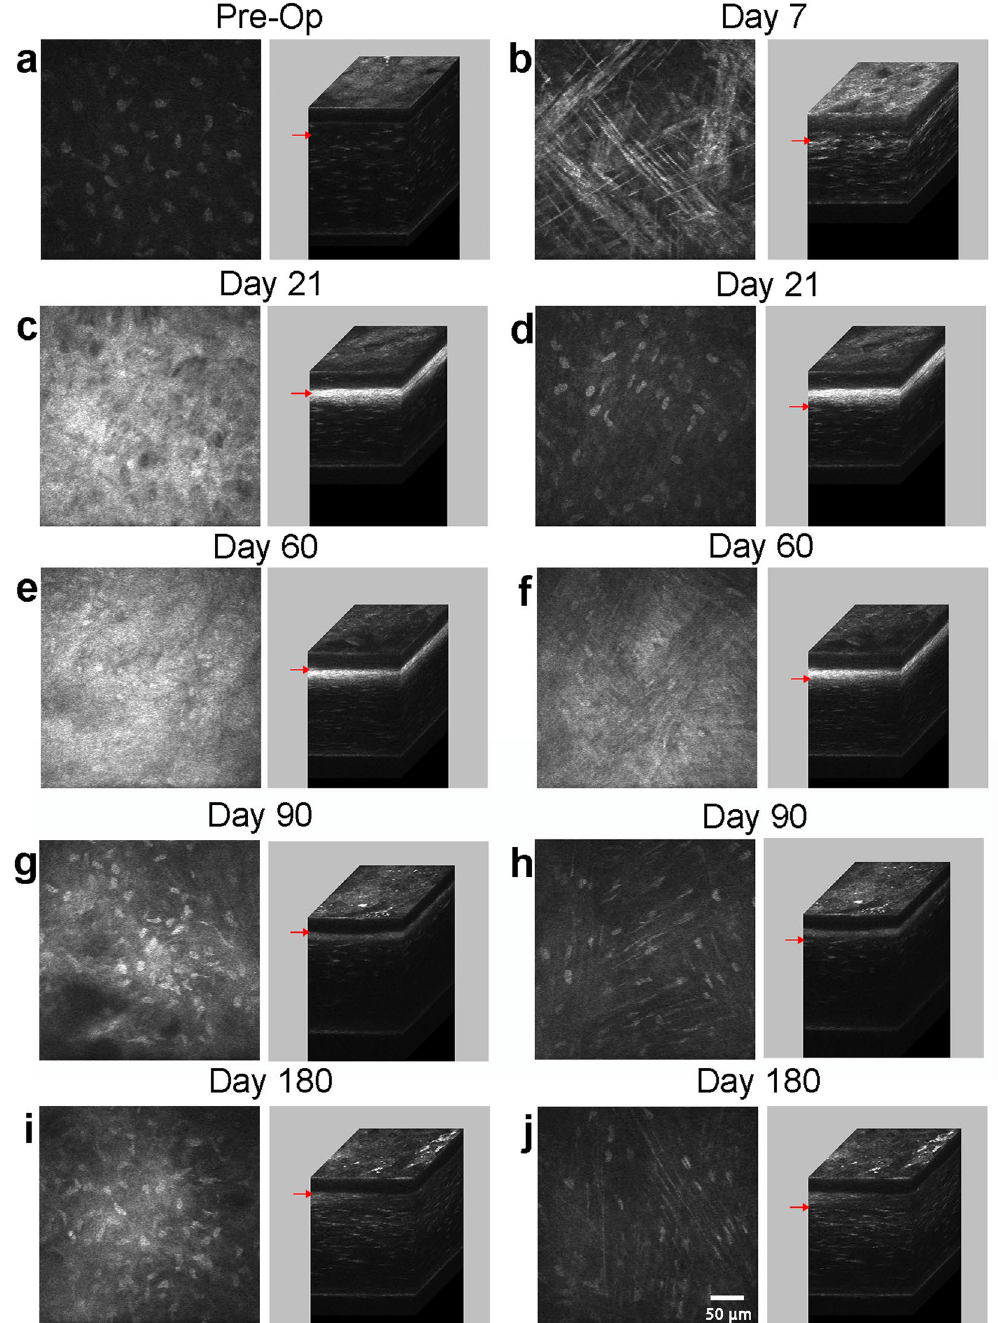
Figure 1. In vivo 2-D confocal images (left) with corresponding 3-D reconstruction of scans (right). Representative images from the ( a ) pre-operative (Pre-Op) cornea, ( b ) 7 days after PRK, ( c , d ) 21 days after PRK, ( e , f ) 60 days after PRK, ( g , h ) 90 days after PRK, and ( i , j ) 180 days after PRK. Images ( a , b ) are from the anterior stroma, ( c , e , g , i ) are from the fibrosis/remodeling region on top of the photoablated surface, and images ( d , f , h , j ) are located in the regenerative region just below the photoablated surface. Arrows indicate the location of each 2-D image within the 3-D